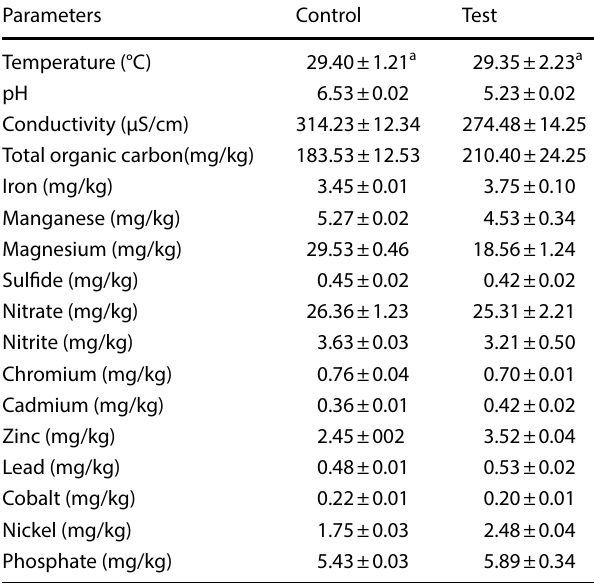
Table 1 Physico-chemical analysis of composite soil